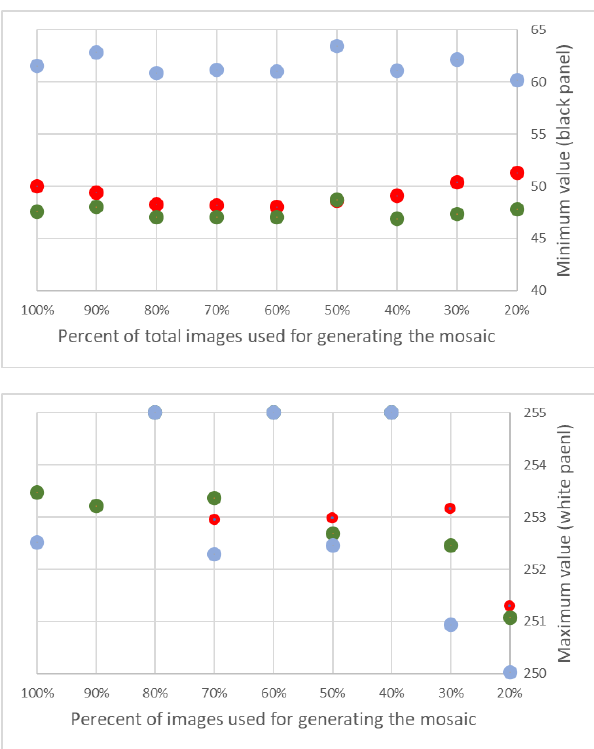
Figure 7 . Minimum, black panel (above) and maximum, white panel (below) values measured in the blue, green, and red bands (as colored dots) from the mosaics generated with different percent of aerial images acquired at 13 meters. The minimum (black panel) values recorded from the mosaics generated with aerial photos acquired at 13 meters, revealed that they were above zero in all three (RGB) bands (Figure 7 above). Minimum values in the blue band (blue dots) were higher in comparison to the red (red dots) and green (green dots) bands. The maximum (white panel) values varied between 250 and 255 for all the RGB bands (Figure 7 below). Unlike the minimum values, the maximum values did not show any distinct pattern across the three (RGB) bands. The minimum (black panel) values recorded from the mosaics generated with aerial photos acquired at 15 meters, revealed that they were also above zero in all three (RGB) bands (Figure 8 above). Minimum values in the blue band (blue dots) were higher in comparison to the red (red dots) and green (green dots) bands. The maximum (white panel) values varied between 251 and 255 for all the RGB bands (Figure 8 below). Unlike the minimum values, the maximum values did not show any distinct pattern across the three (RGB) bands.